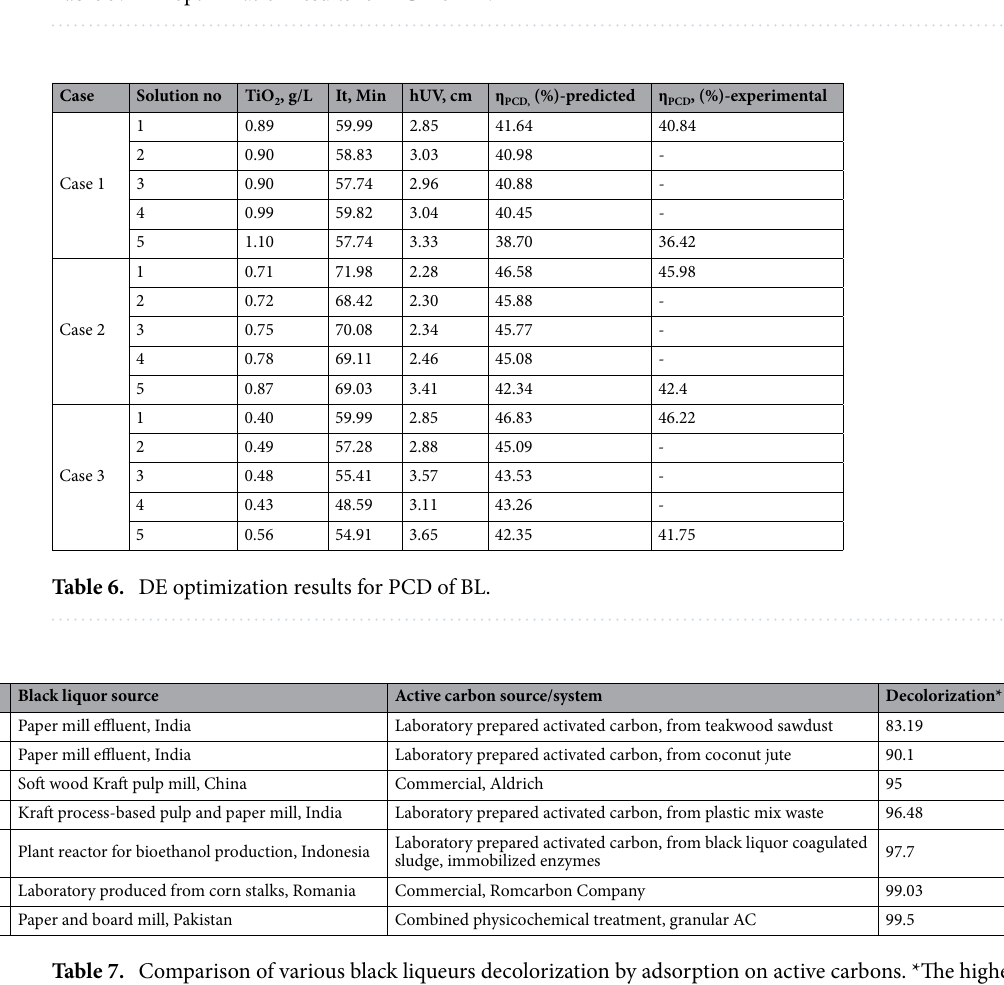
Table 7. Comparison of various black liqueurs decolorization by adsorption on active carbons. *The highest reported